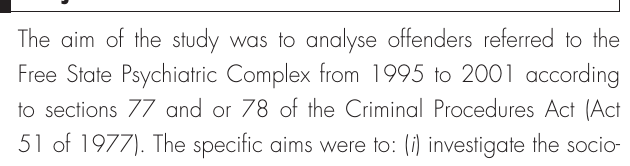
Table I. Mental health status of evaluated offenders reffered according to sections 77 and/or 78 of the Criminal Procedures Act Source No mental illness or defect (%) Mental disorders (%) Slabber et al.